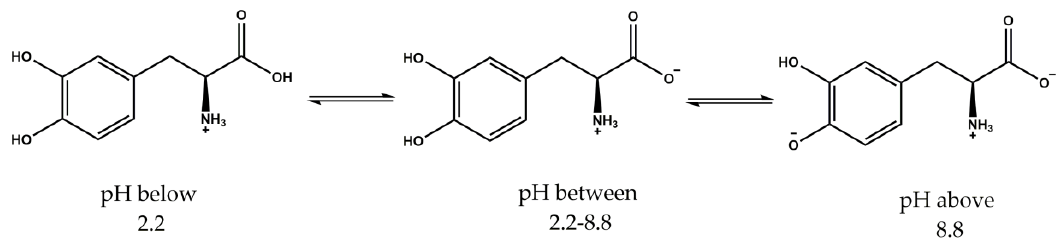
Figure 6. L-DOPA ’s plausible ionic structures at different pH values. Figure 6. L-DOPA’s plausible ionic structures at different pH